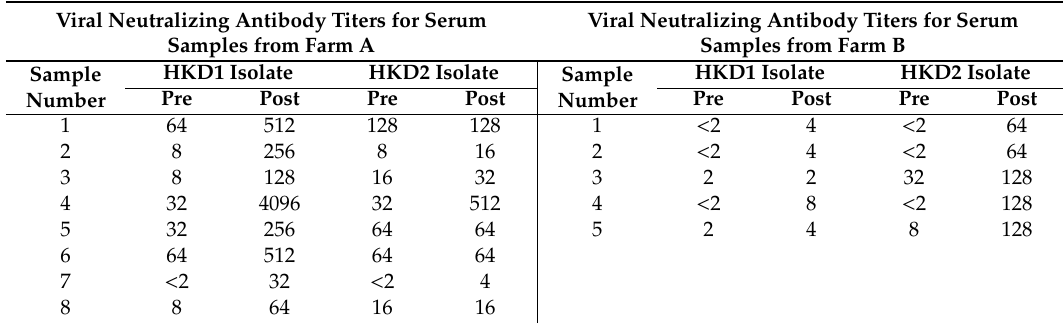
Table 4. Viral neutralizing antibody titers of serum samples collected in the acute (pre) and recovery (post) phases of BRD outbreaks that occurred at farms A and B against bovine influenza D viruses (HKD1 and HKD2) isolated from the two farms, as measured using a neutralization assay. Viral Neutralizing Antibody Titers for Serum Viral Neutralizing Antibody Titers for Serum Samples from Farm A Samples from Farm B Sample